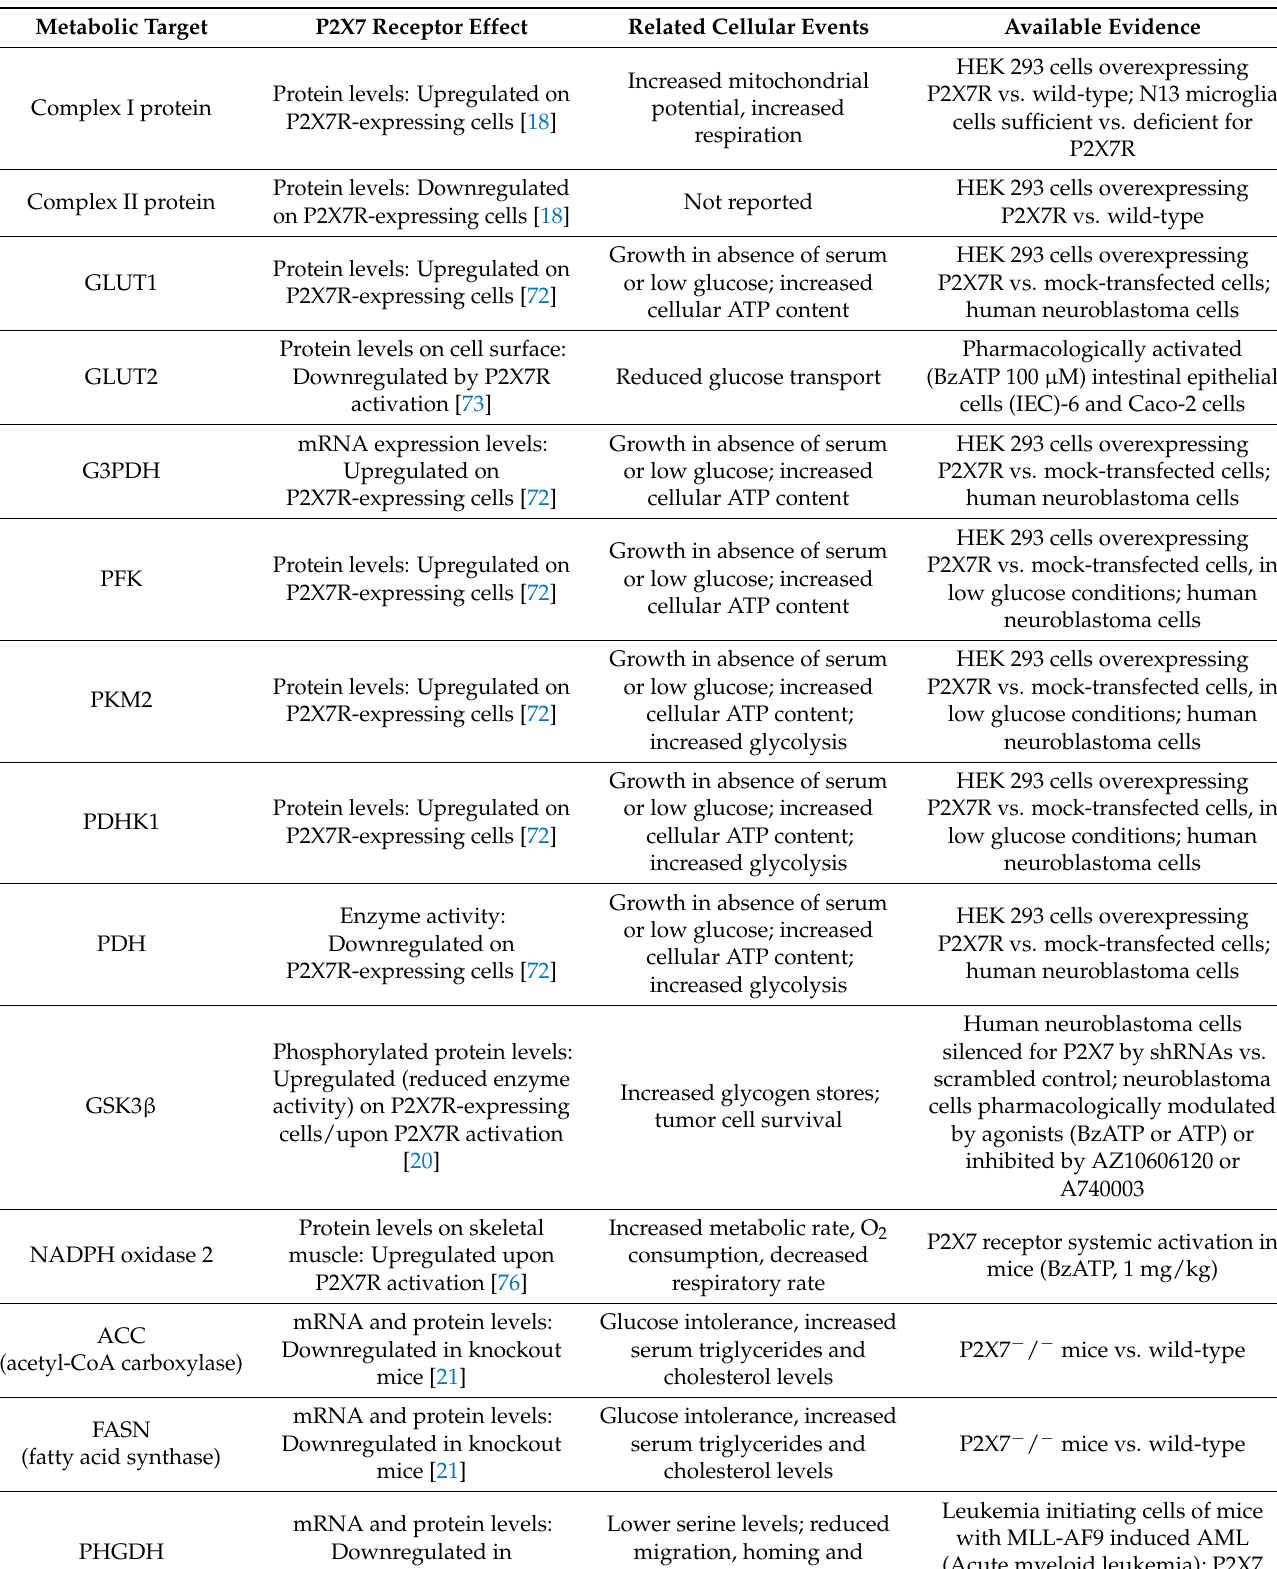
Table 1. Summary of metabolic targets modulated by P2X7 receptor expression and/or activation and observed cellular